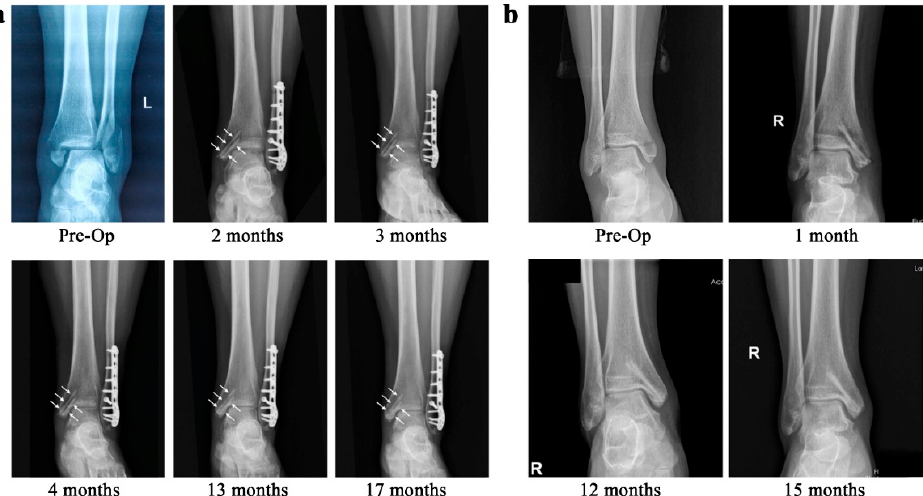
Figure 3. ( a ) Preoperative and postoperative radiographs of a young female patient with a trimalleolar fracture. Two Mg–Nd–Zn–Zr alloy screws coated by Ca–P coating (white arrows) were implanted for the treatment of the medial malleolar fracture. Both screws did not indicate signs of failure before fracture healing as they maintained their morphology. The radiographs also indicated the degradation process seventeen months post-surgery. ( b ) Preoperative and postoperative radiographs of a mid-age female patient with a medial malleolar fracture. The patient’s radiograph indicated radiolucent zones around screws one month postoperatively, which almost disappeared twelve months postoperatively. L and R show Left medial malleolus and Right medial malleolus. Reprinted with permission from ref. [197]. Copyright 2021, Elsevier.